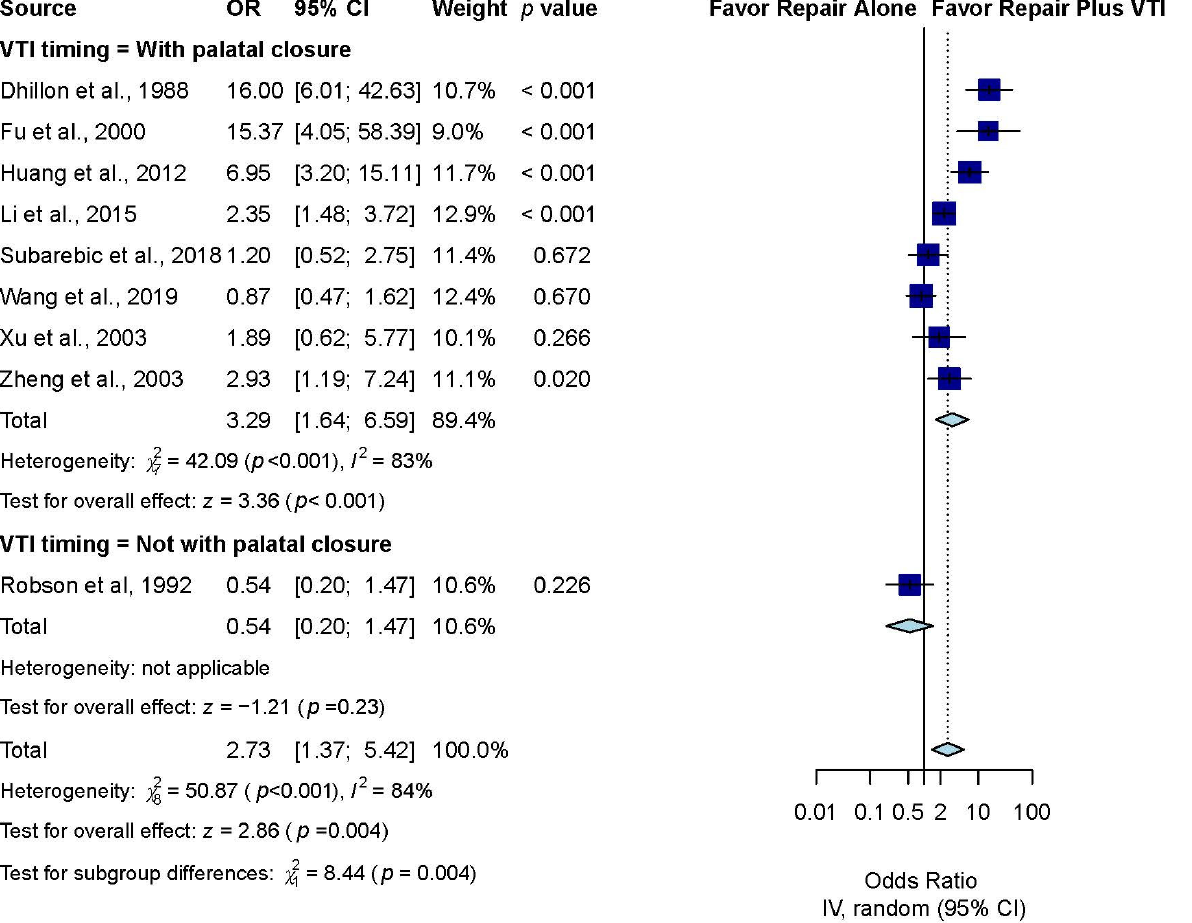
Figure 3. Subgroup analysis of OME-free rate by VTI timing.